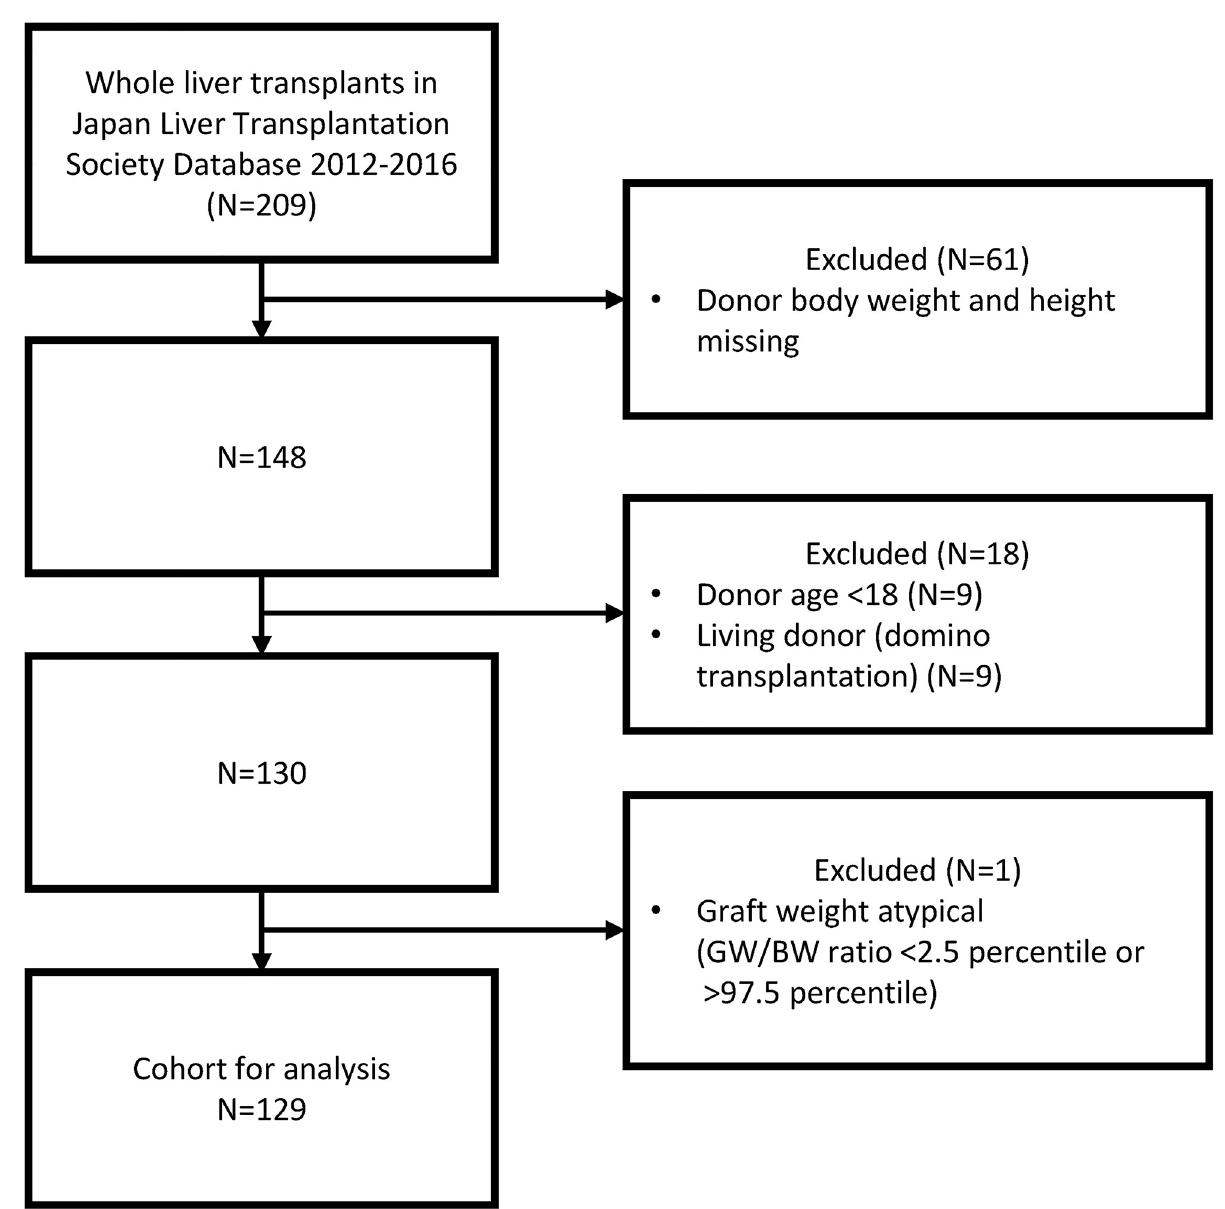
Fig 1. Selection of donor/graft pairs. There were no missing values in age, sex, or graft weight.